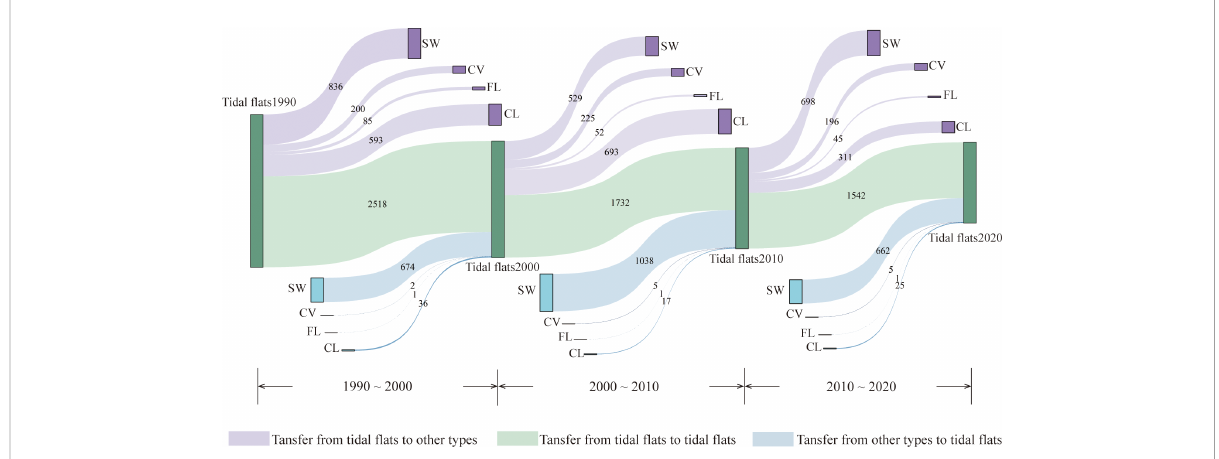
FIGURE 4 Sankey diagram of tidal fl at conversion in the Yangtze River Delta (km 2 ) (SW, seawater; CV, coastal vegetation zones; FL, farmland and forestry land; CL, construction land).